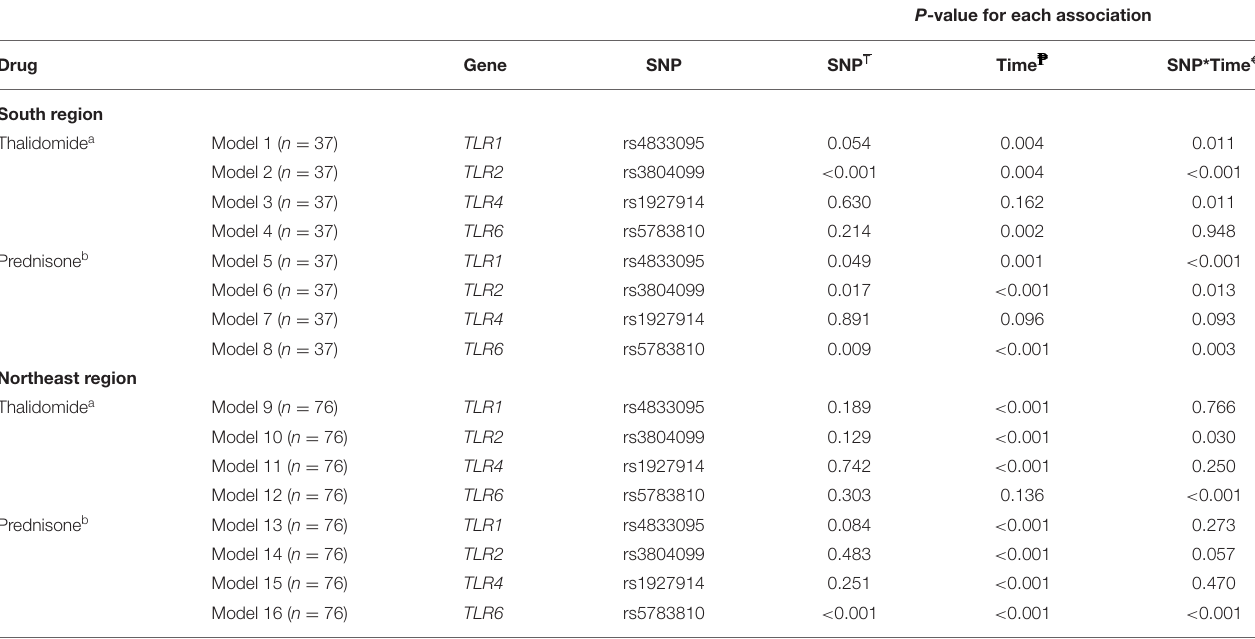
TABLE 4 | P -values for the association of genotypes of TLR polymorphism, time and genotype * time interaction on dose of thalidomide or prednisone, as obtained in eight separate analyses for each drug and SNP using the Generalized Estimates Equation model (GEE).